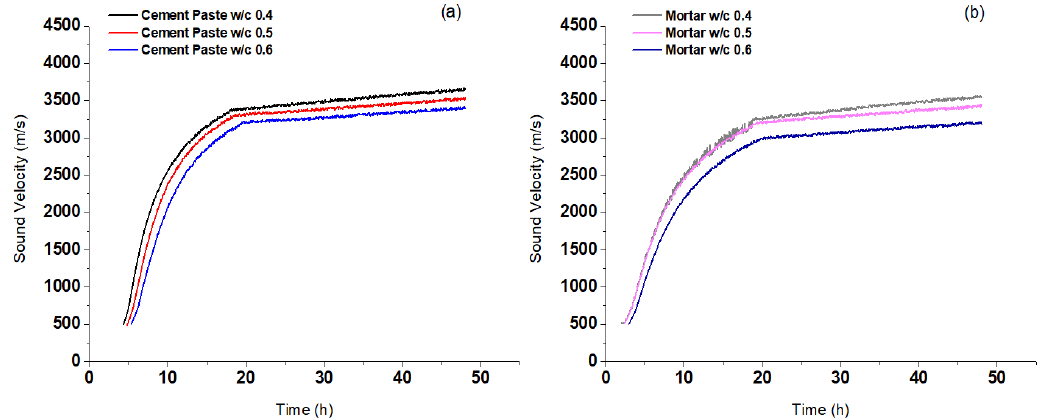
Figure 3. Sound Velocity for different w/c ratios for ( a ) cement paste and ( b ) mortar.